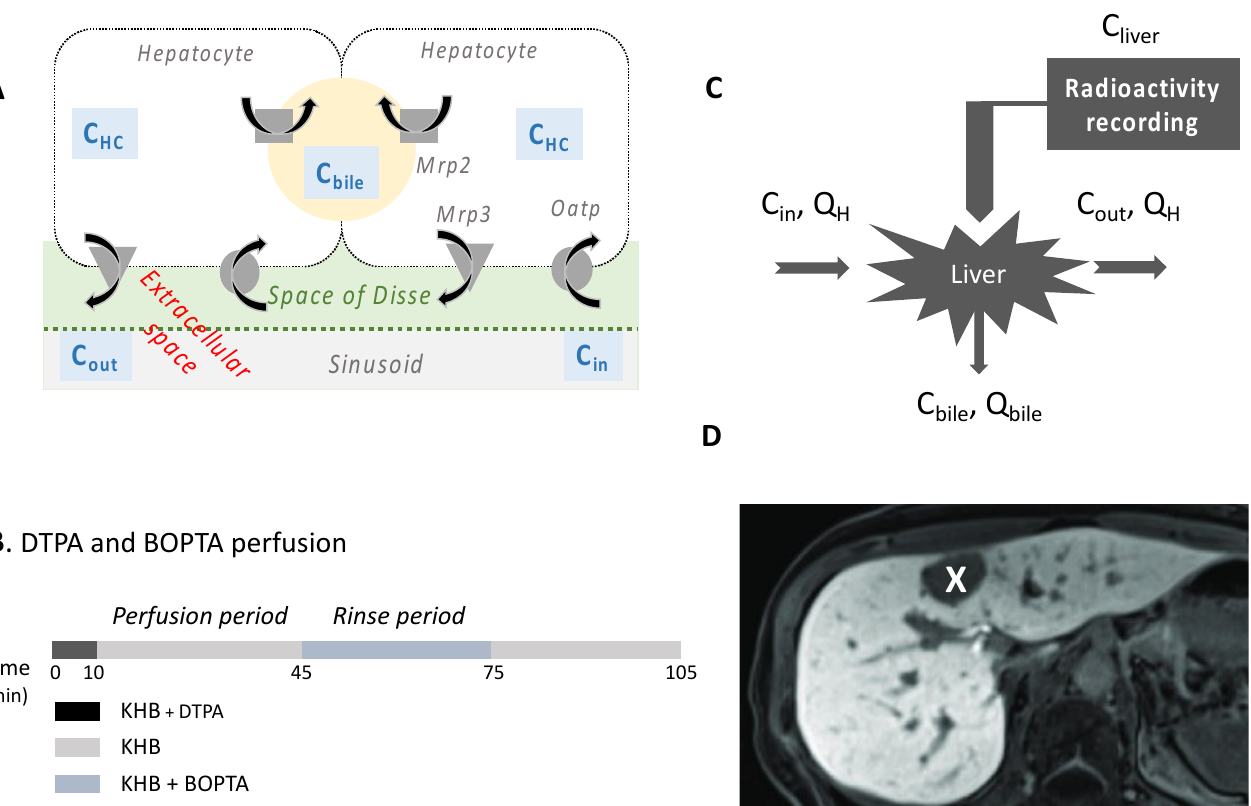
Figure 1. ( A ) BOPTA enters hepatocytes through the rat organic anion-transporting polypeptides (Oatps) and exits from hepatocytes into the bile canaliculi through the multidrug-resistance-associ- ated protein 2 (Mrp2) and back into the sinusoids through Mrp3/4. ( B ) Two imaging substrates, DTPA and BOPTA, are subsequently perfused in isolated rat livers. DTPA distributes within the extracellular space (sinusoids and space of Disse), while BOPTA distributes into the extracellular